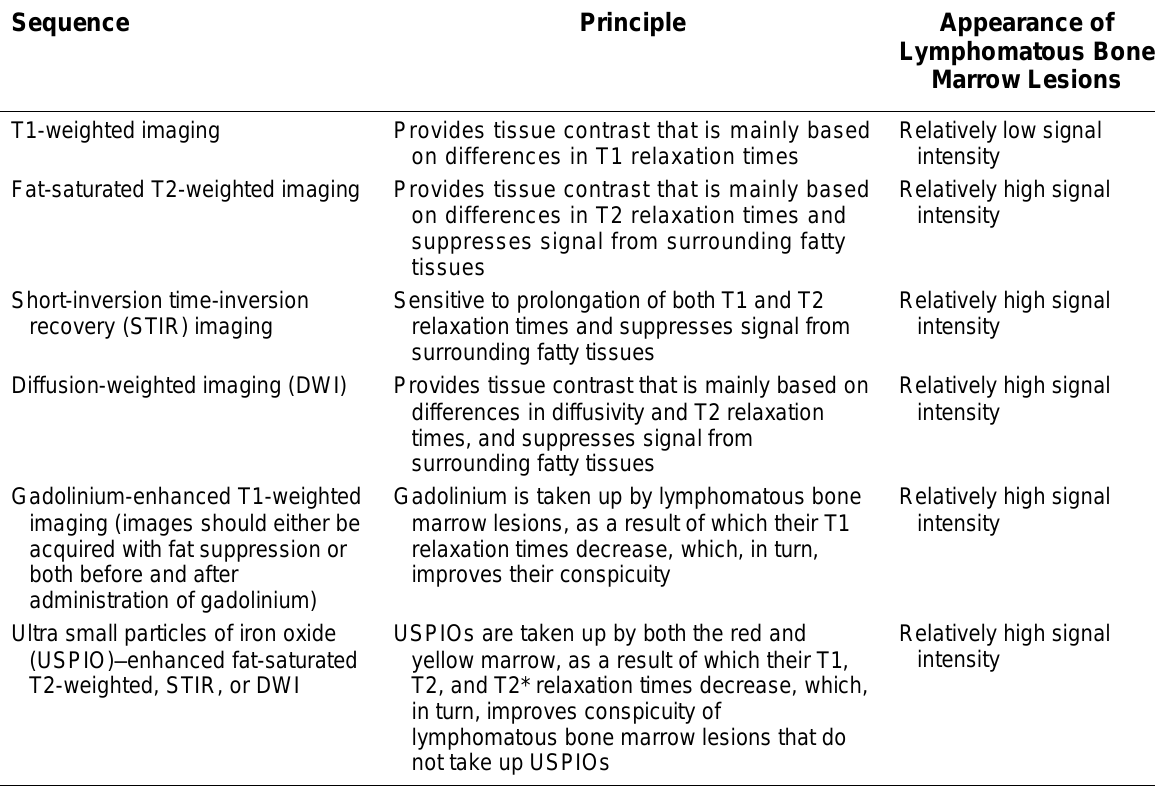
Main Characteristics of MRI Sequences that can be Used for the Evaluation of the Bone Marrow in Patients with